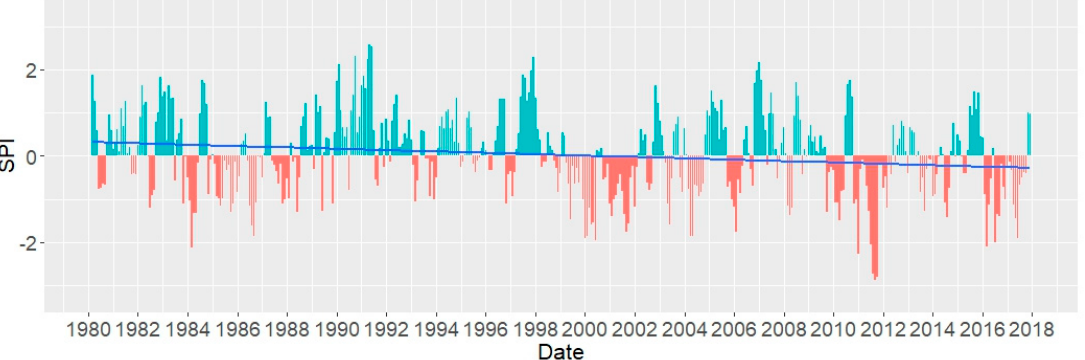
Figure 8. Three-month SPI of the Zhob station.